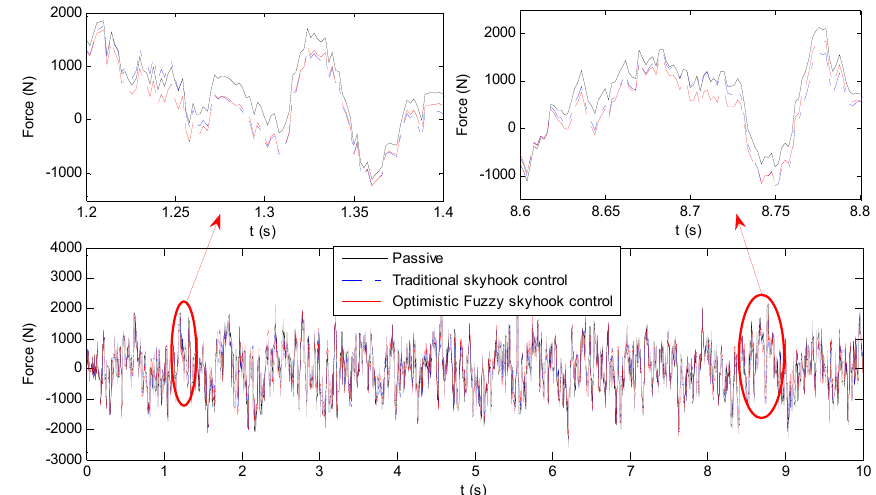
Figure 18. Comparison of the tire dynamic loads using the three control methods under C class road excitation.